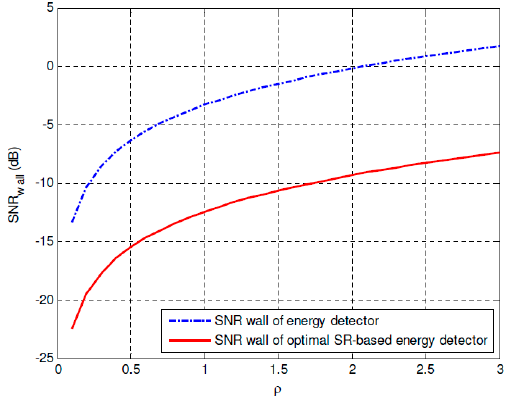
Figure 8. SNR walls comparison under SNR i = − 30 dB.